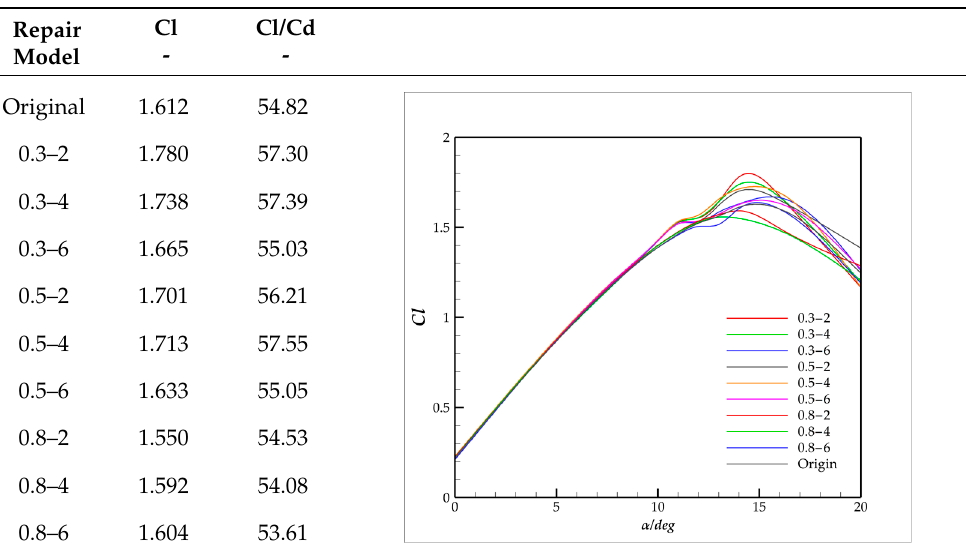
Table 5. Lift coefficient and lift–drag ratio of 2D aerodynamic repair model.